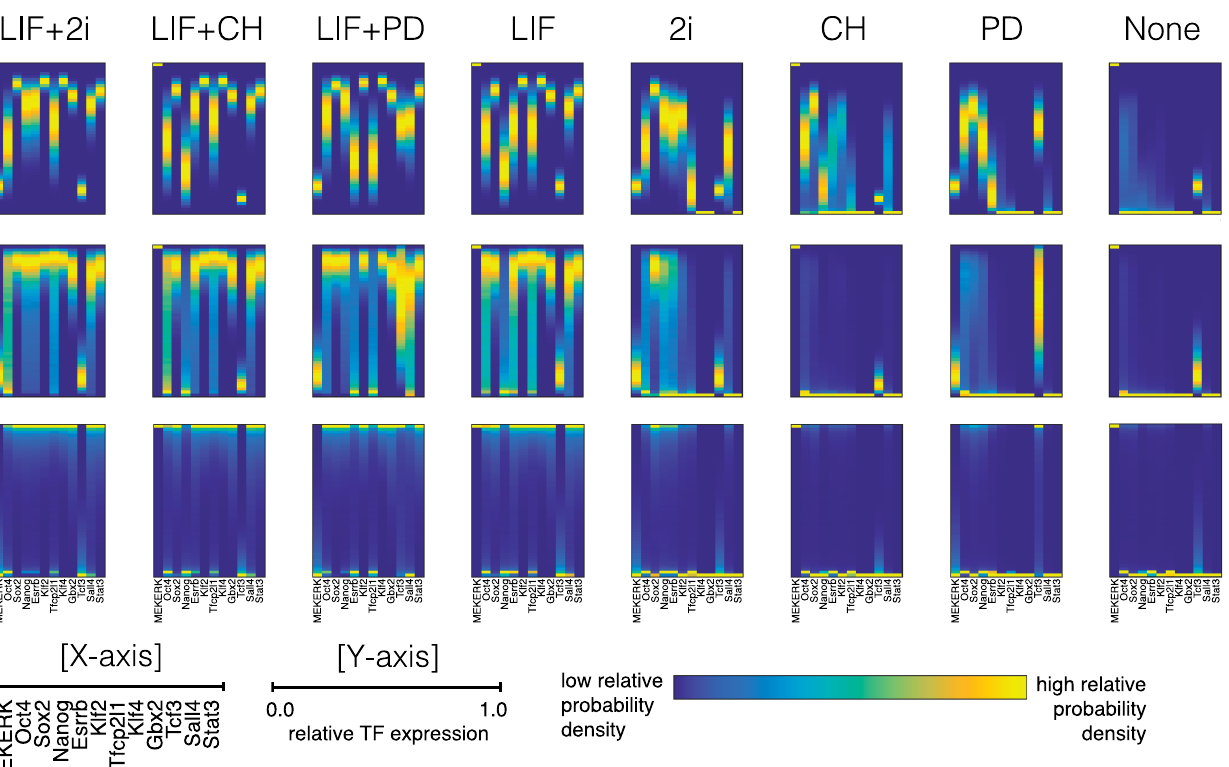
PLOS Computational Biology | https://doi.org/10.1371/journal.pcbi.1006000 February16,